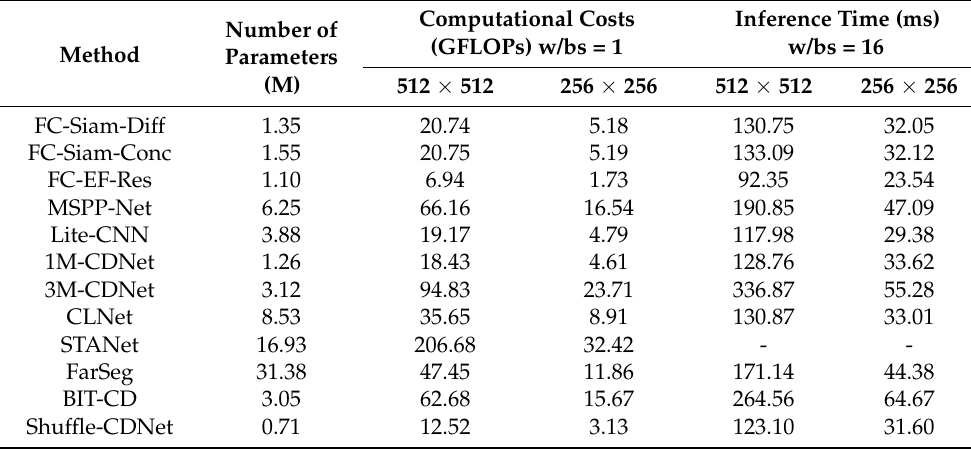
Table 1. Comparison of network parameters, computational costs, and inference